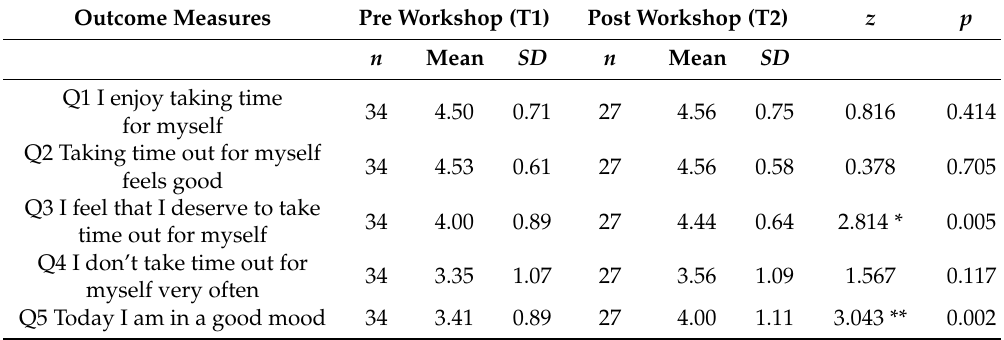
Table 2. A table showing the MDT’s outcome measures for T1 and T2, z -scores and p -values. Outcome